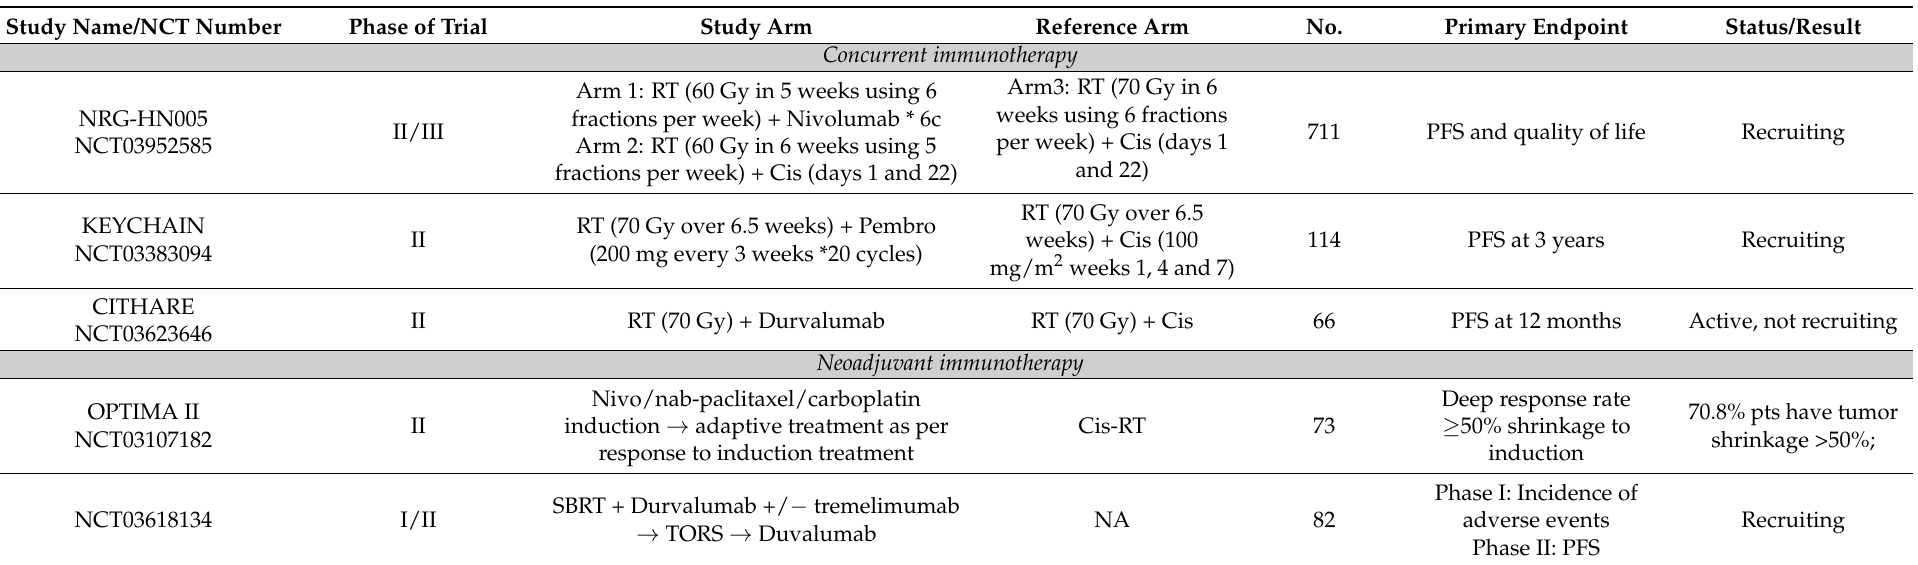
Table 2. Clinical trials involving RT with immunotherapy in HPV related oropharyngeal